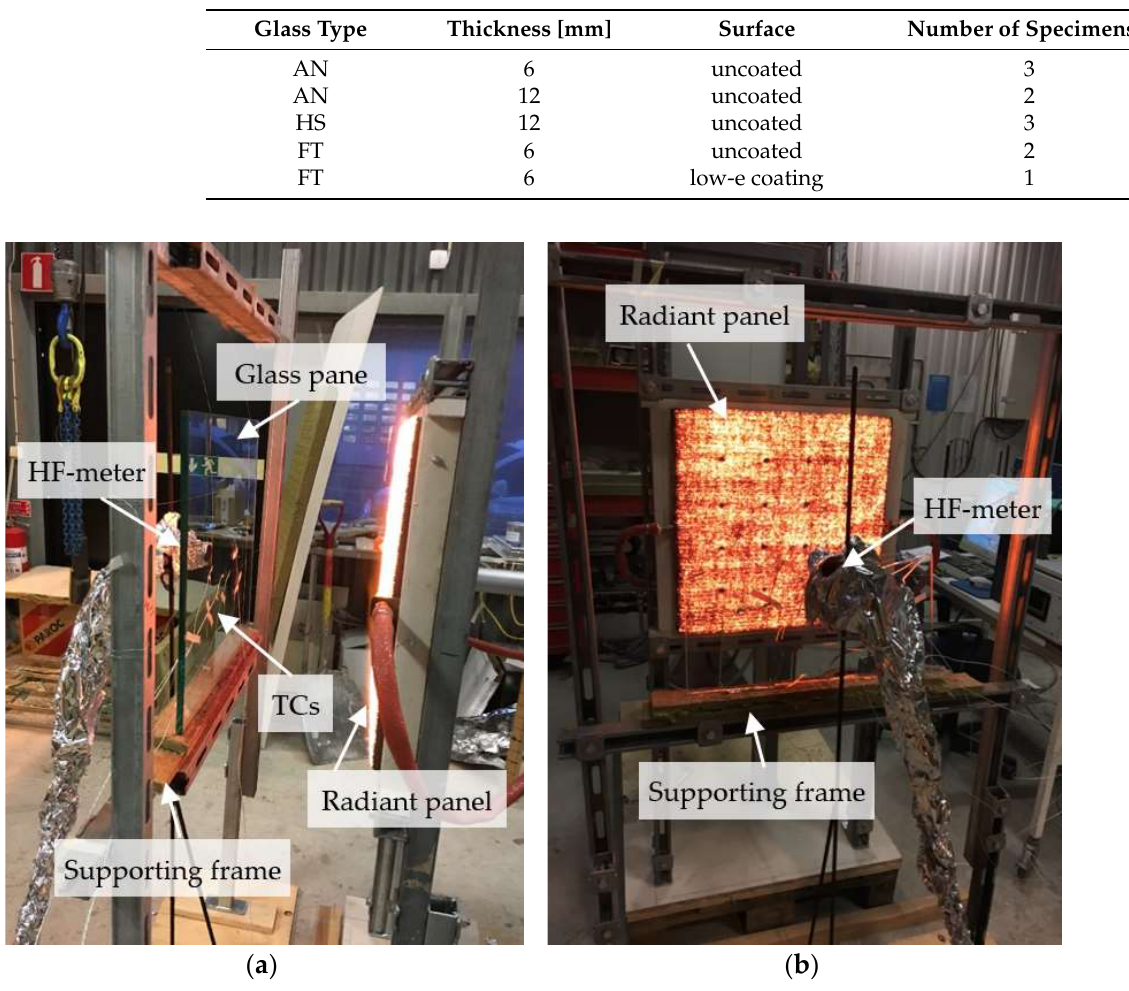
Figure 3. ( a ) Side view of specimen in the supporting frame with the radiant panel to the right and the HF-meter behind the specimen to the left; ( b ) View from the back of the glass specimen.